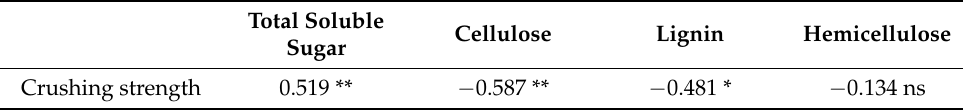
Table 2. Correlations among carbohydrates and the crushing strength of maize stalks.